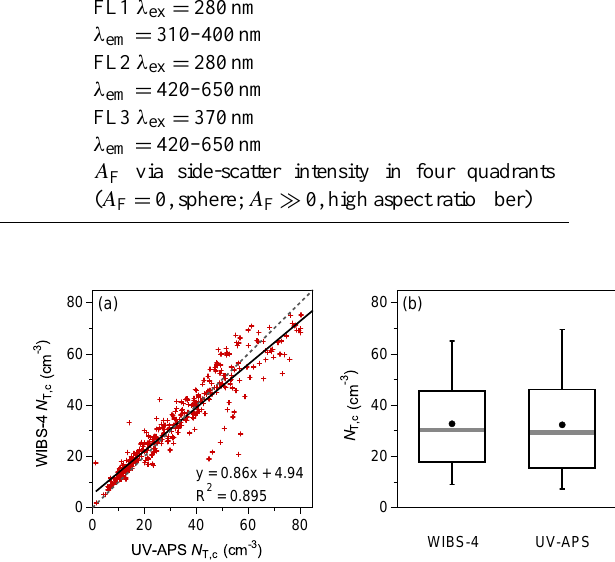
mobile laboratory trailer. Measurements were made at 5 min